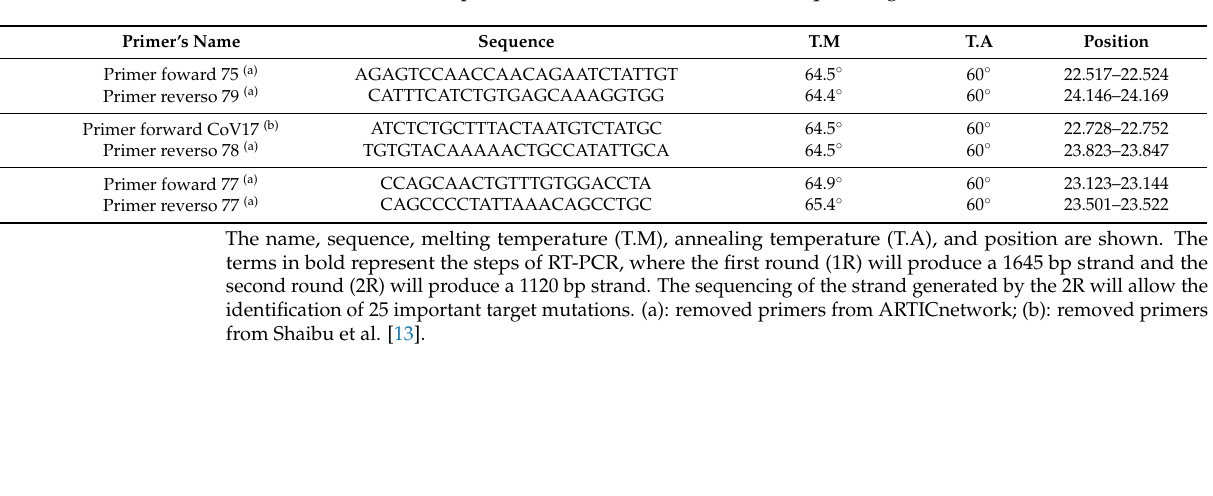
Table 1. Information of primers used in nested PCR and